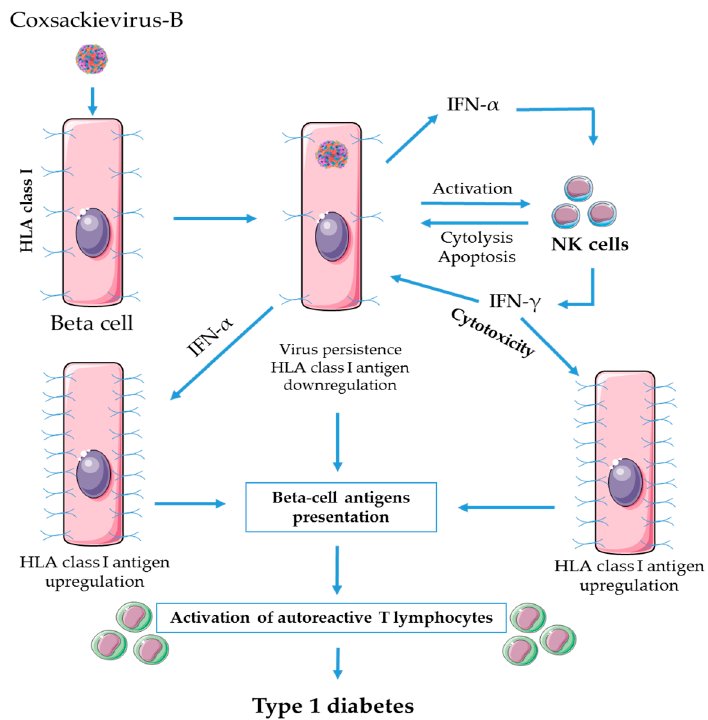
Figure 2. NK cells in the pathogenesis of virus-induced type 1 diabetes during persistent CV-B infection: possible mechanisms. Persistent CV-B infection inhibits the expression of HLA class I molecules on human pancreatic beta cells. NK cells induce apoptosis of virus-infected cells that have altered or downregulated surface expression of HLA class I molecules. Apoptotic beta cells can direct immune response towards autoimmunity through autoreactive T lymphocyte activation. Moreover, IFN- α produced by infected beta cells enhances NK cells cytolytic activity while IFN- γ produced by NK cells damages beta cells (infected and non-infected) by direct cytotoxicity. IFN- α and IFN- γ are able to upregulate HLA class I expression on beta cells leading to increase immune recognition and activation of autoreactive T cells and hence autoimmunity towards beta